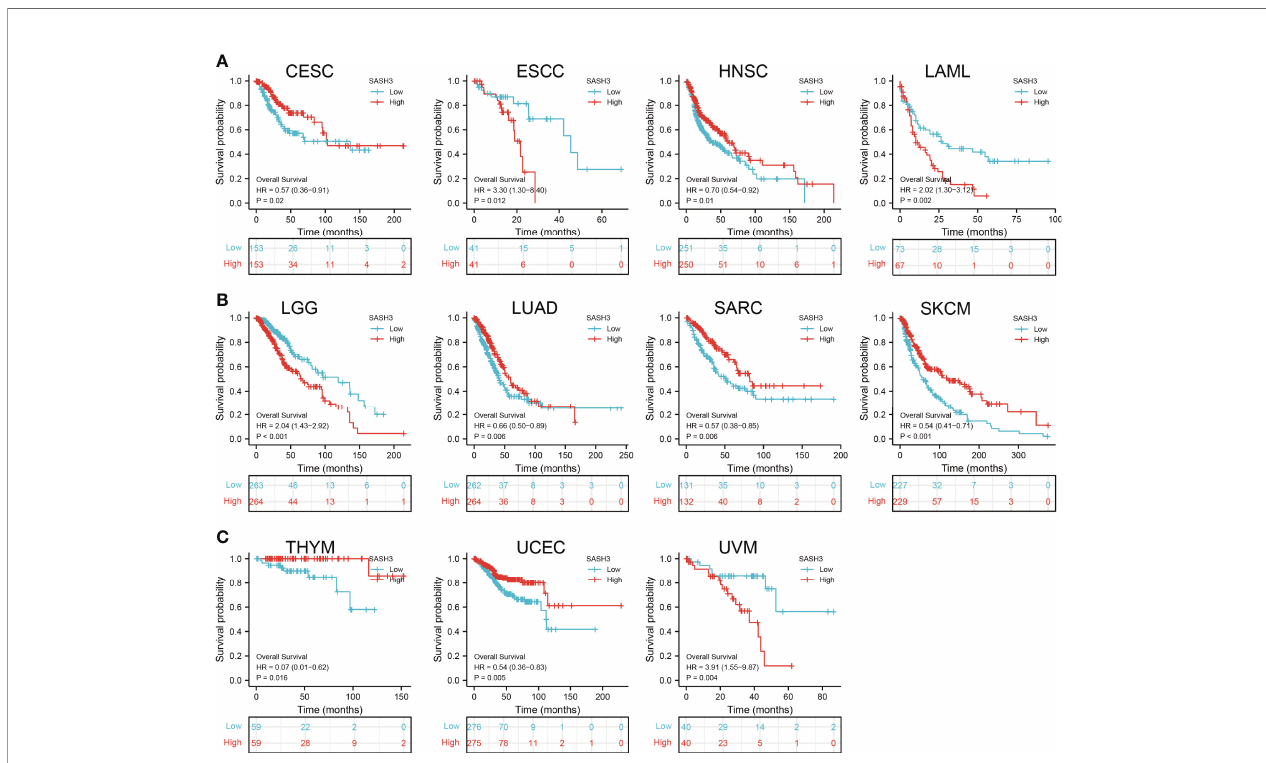
FIGURE 2 | SASH3 expression correlated with the overall survival of pan-cancer. (A) The overall survival for SASH3 in CESC, ESCC, HNSC, and LAML. (B) The overall survival for SASH3 in LGG, LUAD, SARC, and SKCM. (C) The overall survival for SASH3 in THYM, UCEC, and